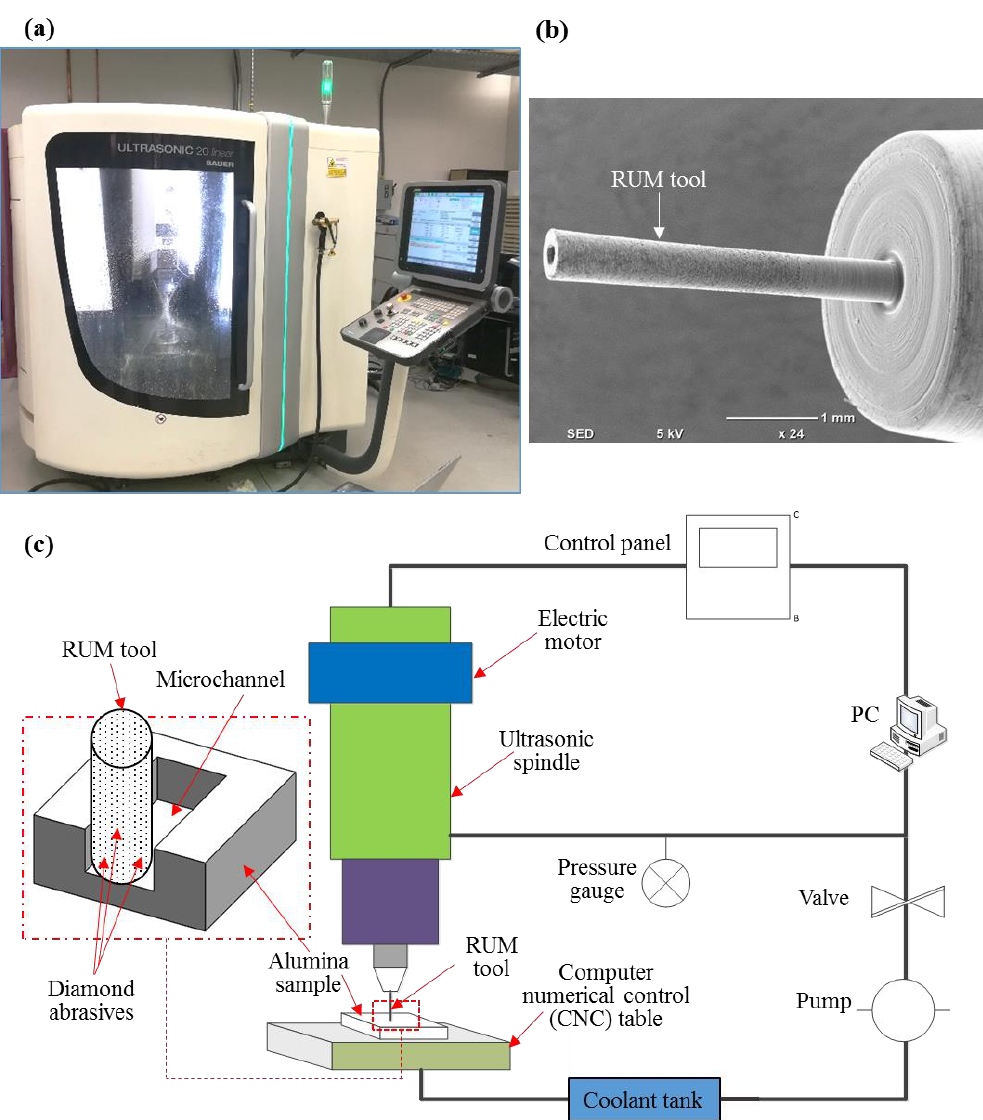
Figure 3. ( a ) Ultrasonic 20 Linear machine, ( b ) MicroRUM tool; ( c ) Schematic diagram of RUM. Table 2. Dimensional specification of microchannels used in this study. Channel Size (µm) Cross-Sections Depth Width Rectangular